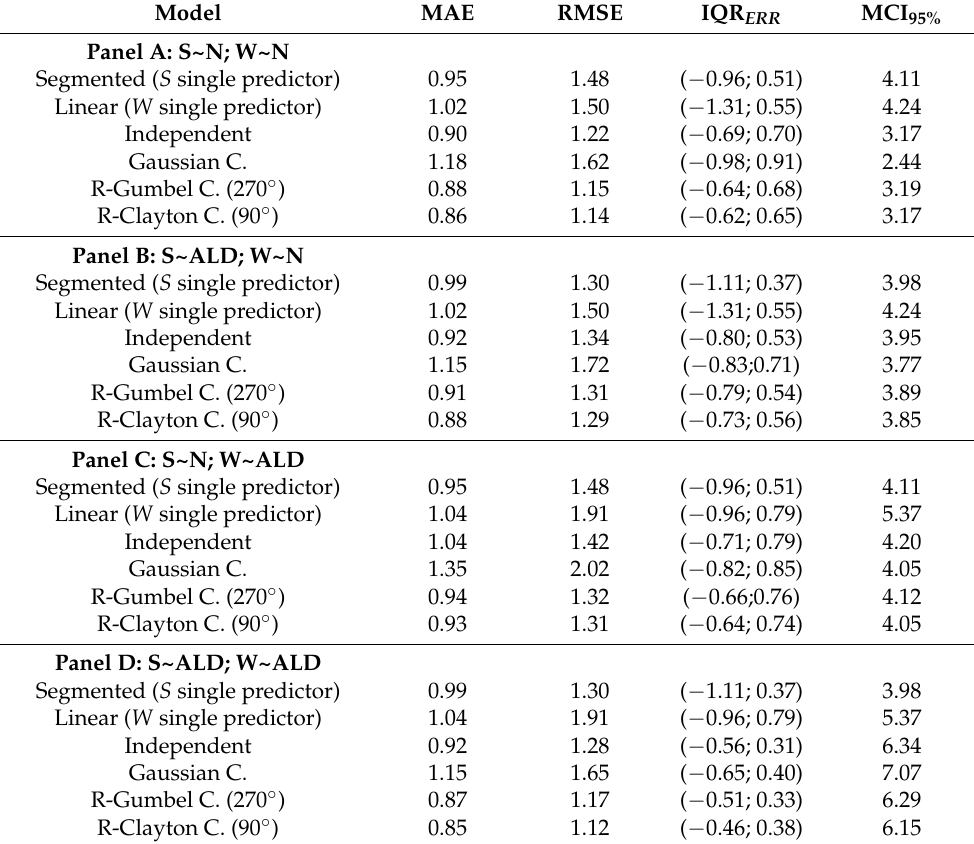
Table A2. Prediction comparison of the considered models with simulated data from Equation (A1) and errors distributed as multinormal-skewed Equation